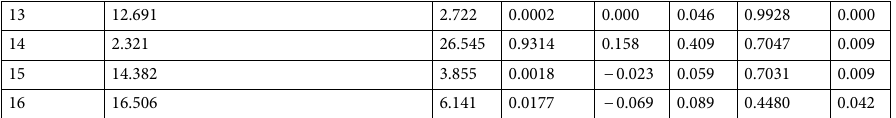
Table 3. Linear regression between segments of the leaf blade (basal, mid-basal, middle, mid-apical and apical portions) and the percentage of anatomical tissues of leaves of contrasting insertion levels along the tiller axis of elephant grass. α intercept, SE standard error, β